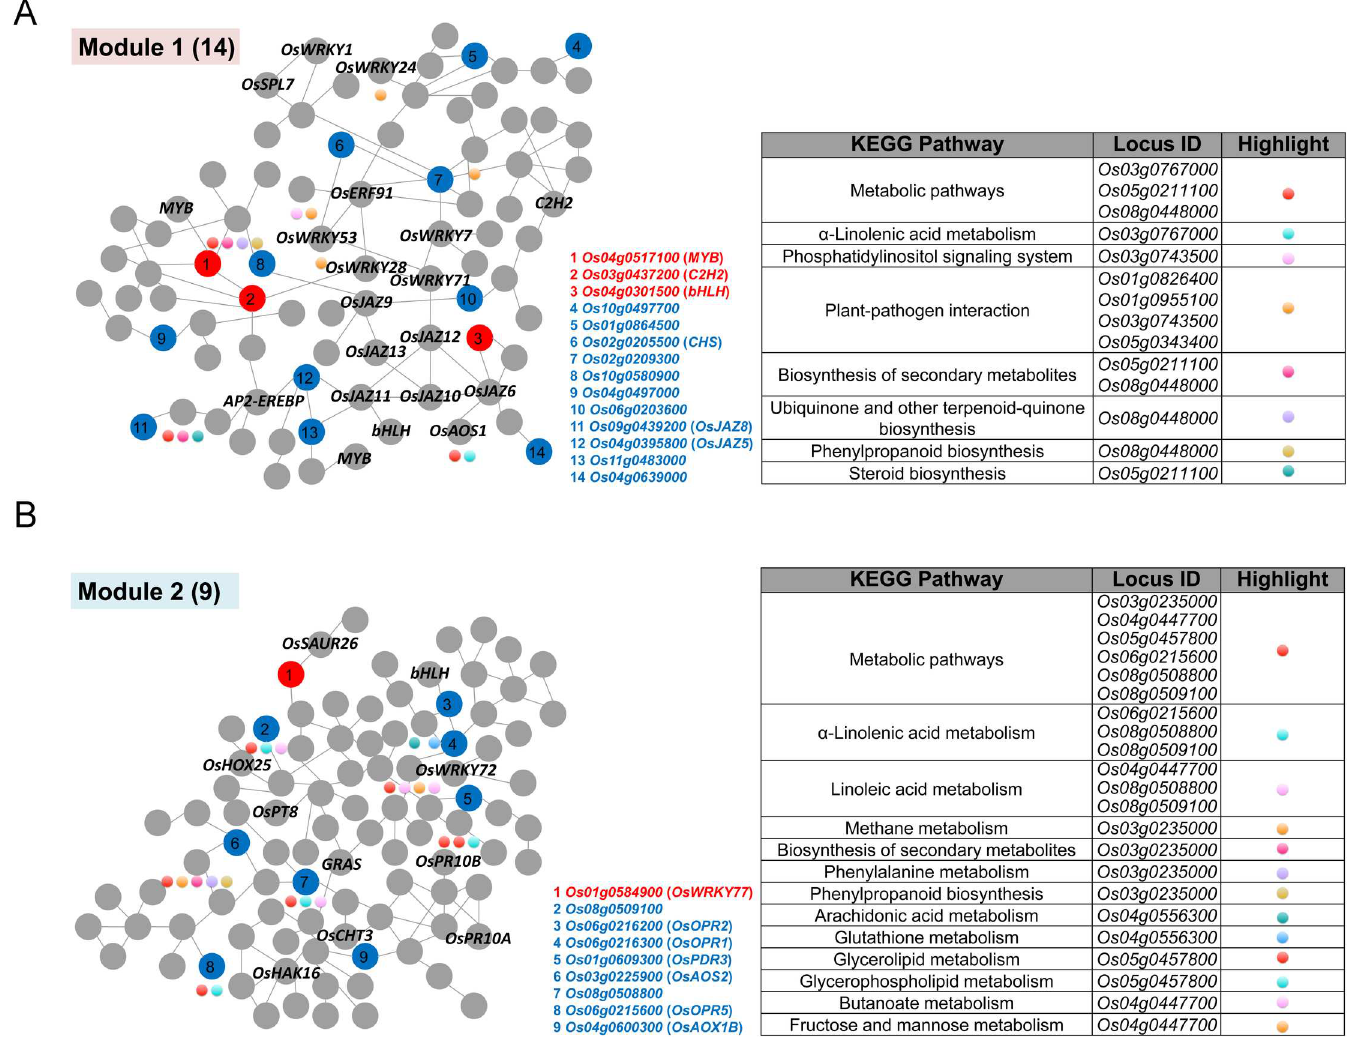
Fig 6. Coexpression network analysis of high C:low N up-regulated genes. (A) Module 1 extracted from coexpression analysis using 14 microarray identifiedgenes. (B) Module2 extracted from coexpression analysisusing 9 microarray identifiedgenes. Red and blue nodes indicate high C:low N up- regulated genes and the red ones are transcription factors. Other genes with known names or encode for transcription factors are marked on the nodes. Genes involvedinto KEGG pathways are marked with color dots beneath the nodes and the detailedinformation are listed on the tables.